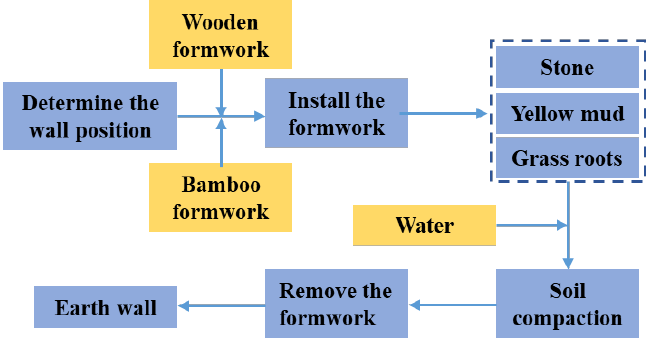
Figure 3. Rammed earth wall production process.